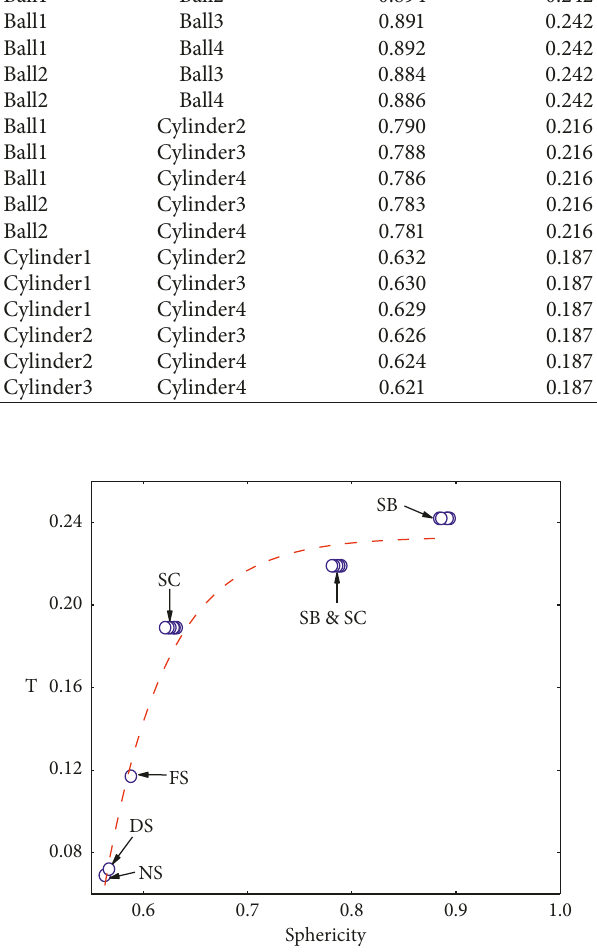
Figure 13: The fitting curve of S - T